Question: According to the figure, is the described quantity increasing or decreasing?
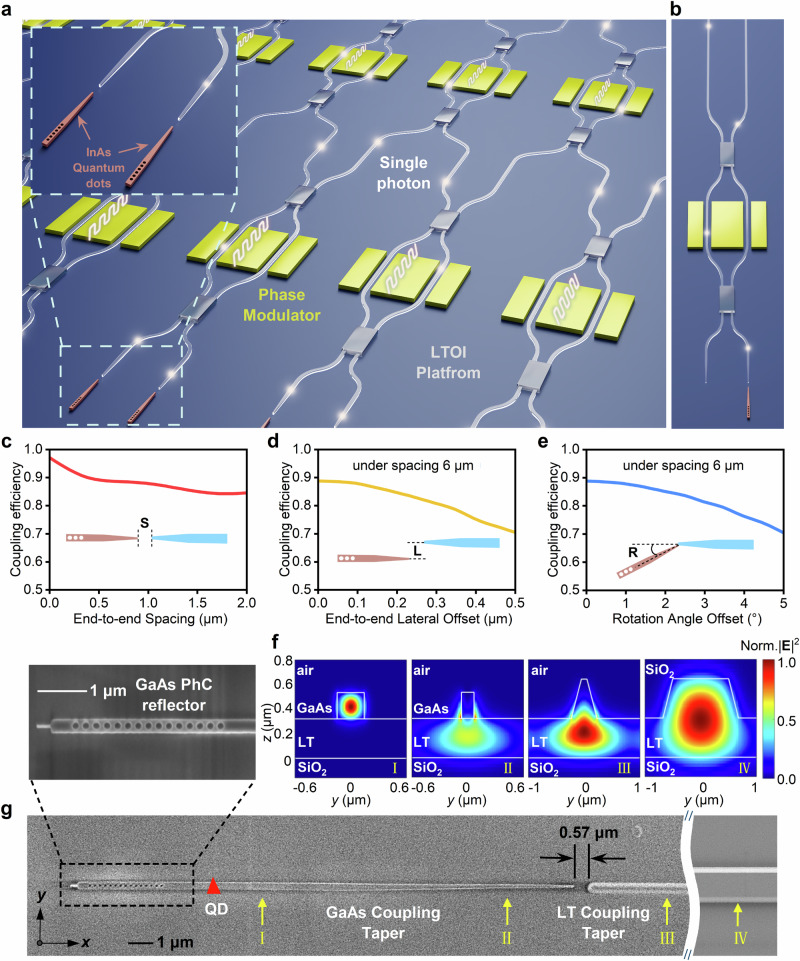
Answer: increasing